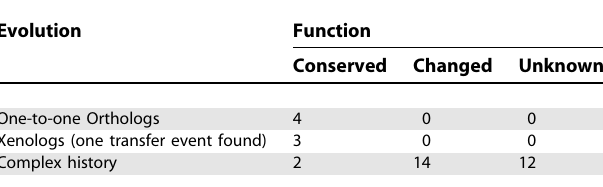
Table 2. Evolutionary and Functional Categories of Bidirectional Best-Hit Transcription Factors from E. coli K12 and B. subtilis